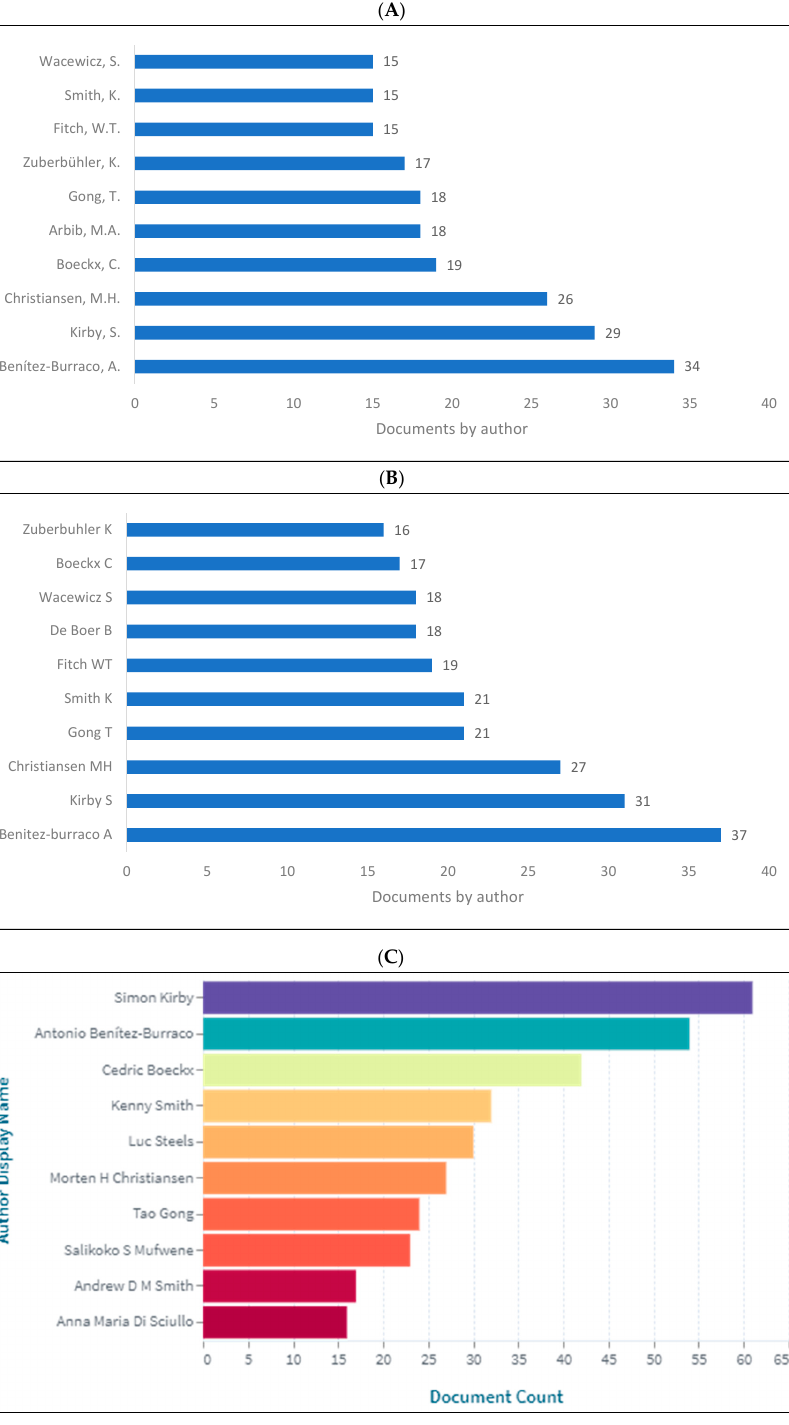
Figure 7. Knowledge production size in biolinguistics by author. ( A ) (Scopus), ( B ) (WOS), ( C ) (Lens).